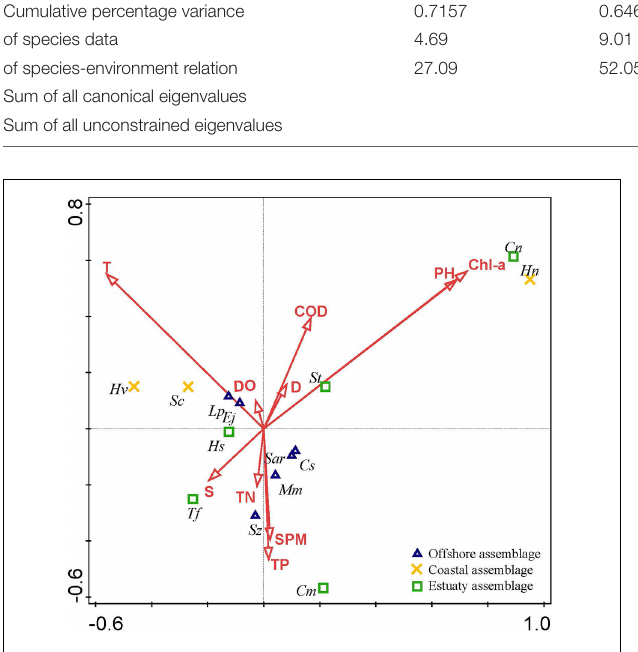
FIGURE 2 | Canonical correspondence analysis (CCA) biplot of ichthyoplankton species in the Yangtze Estuary in spring 2013–2020. The black font indicated the abbreviate name of the species as shown in Table 1 .